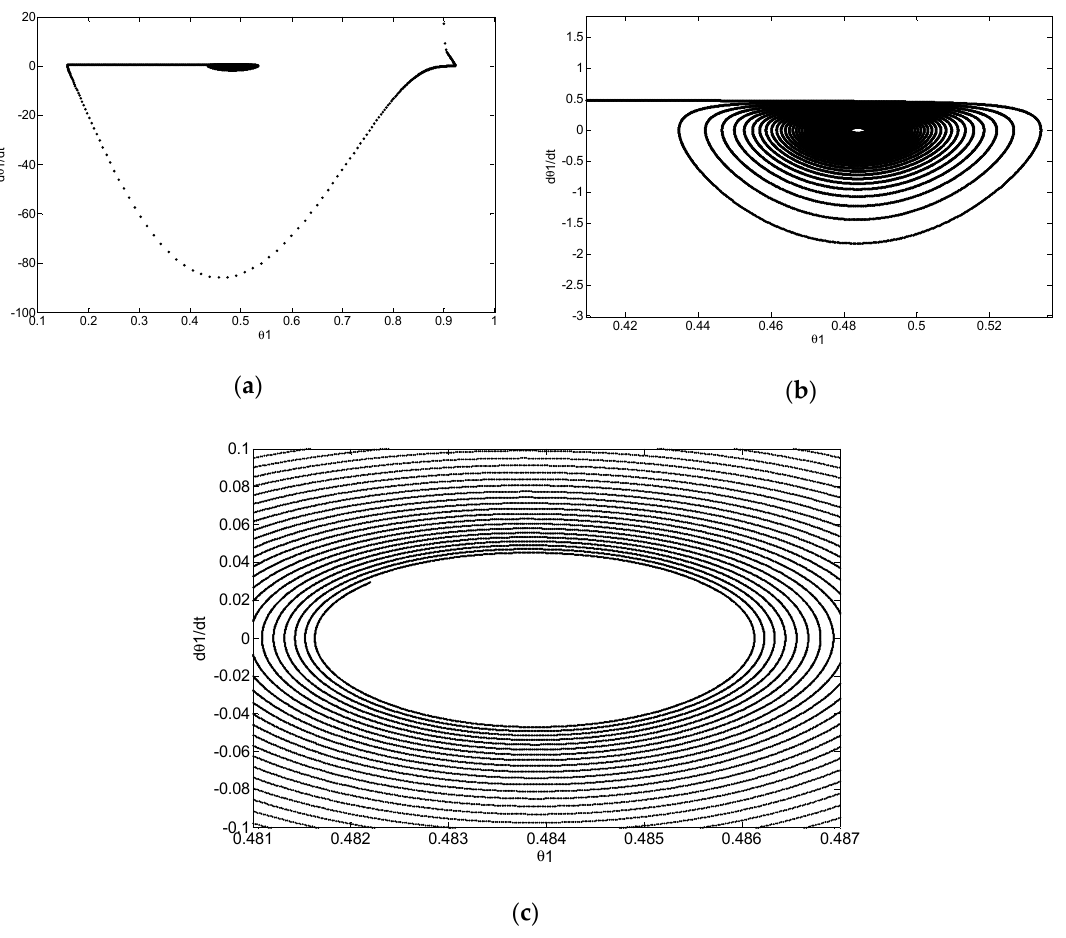
Figure 10. Superficial fractional coverage of carbon monoxide phase plane at 99.992 Pa and time step = 2·10 − 4 s. ( a ) without zoom, ( b ) zoom on the spiral and ( c ) more precise zoom on the spiral.